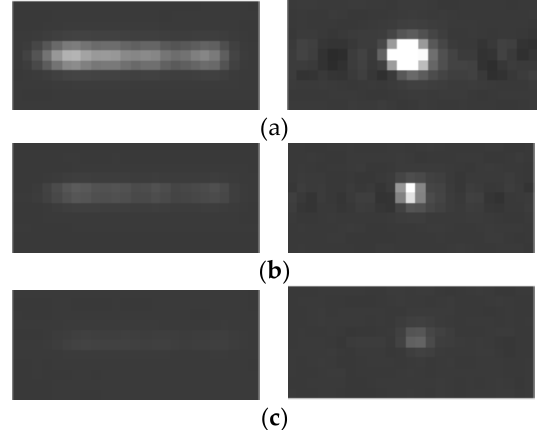
Figure 22. Brightness comparison before and after restoration. ( a ) Brightness comparison of high brightness star strip before and after restoration. ( b ) Brightness comparison of mid brightness star strip before and after restoration. ( c ) Brightness comparison of low brightness star strip before and after restoration.